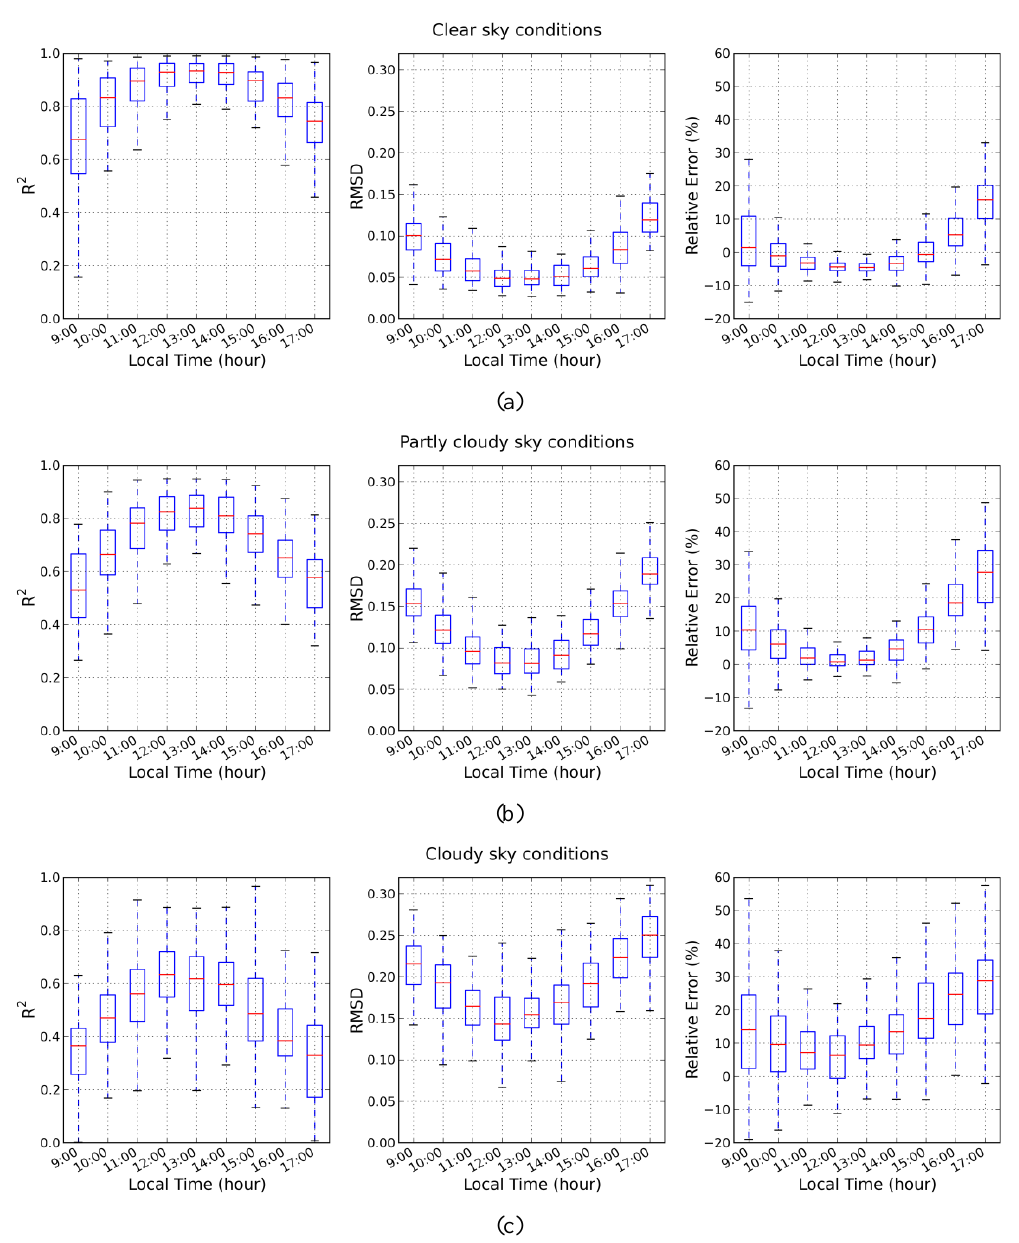
Fig. 3. Box plots of statistical results for the comparisons between instantaneous EF at different times of day and daytime EF for all the FLUXNET sites (number=72) under different sky conditions: (a) clear sky; (b) partly cloudy sky; and (c) cloudy sky. Each box covers the range between the 0.25 and the 0.75 quartile, the median value is drawn as a horizontal red line, and the whiskers indicate the range of the data within the maximum and the minimum values.